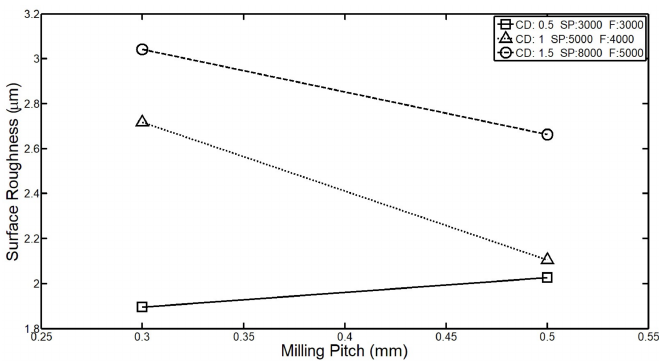
Figure 6. The influence of milling pitch on surface